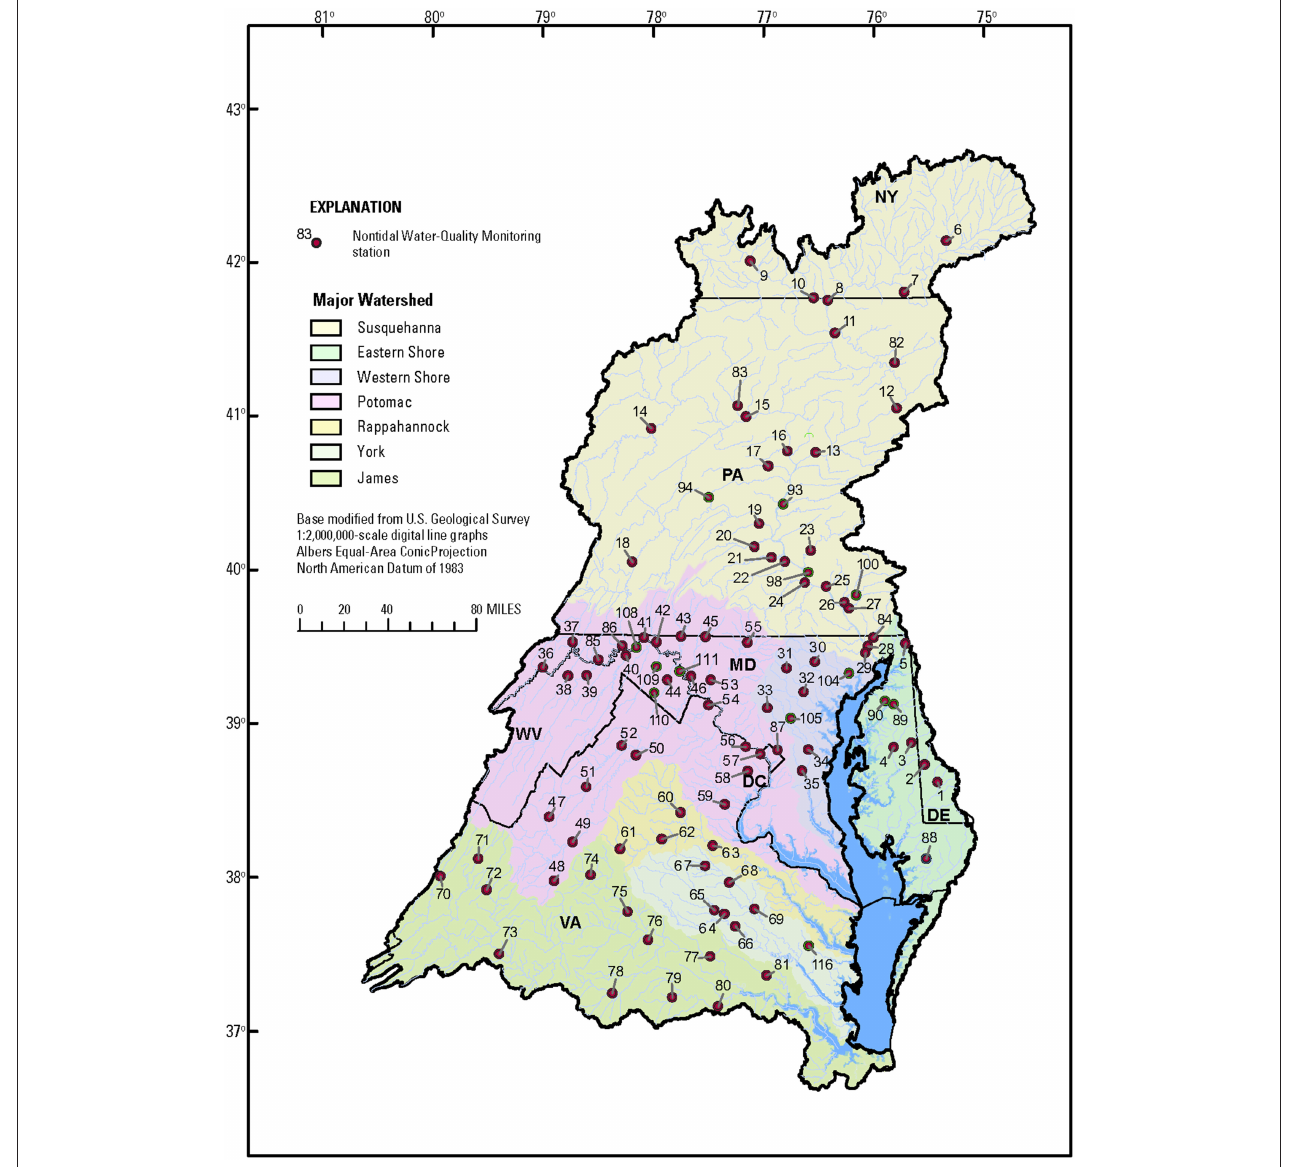
FIGURE 1 | Map of the Chesapeake Bay watershed and sites in the Chesapeake Bay Nontidal Monitoring